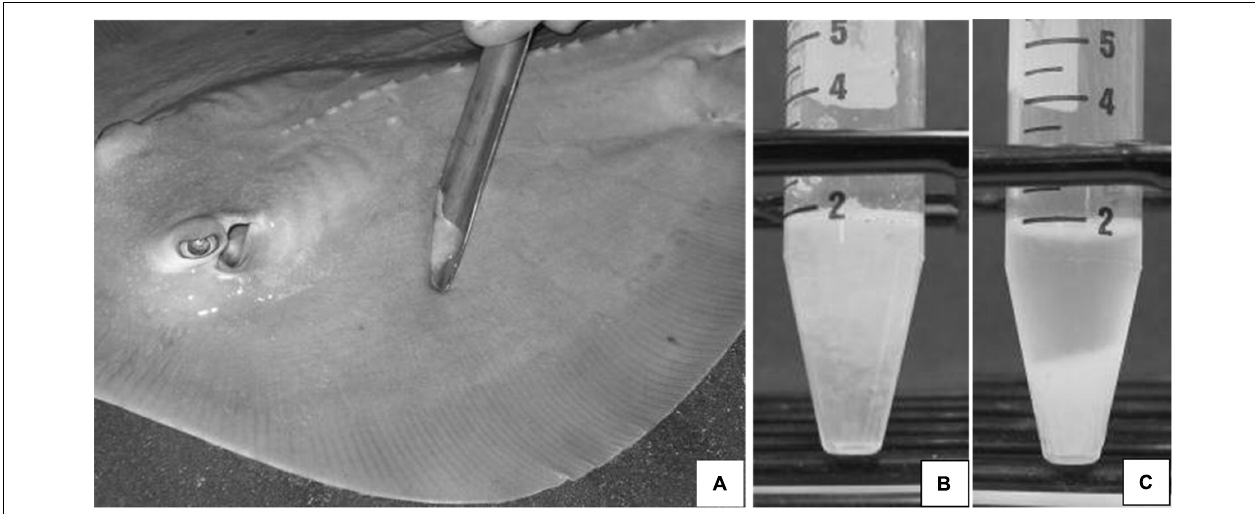
FIGURE 1 | (A) Epidermal mucus is collected by passive scraping of the pectoral fin surface of an Atlantic stingray, Dasyatis sabina with a sterile scoopula. Fresh mucus (B) can be separated into an aqueous supernatant and a mucus pellet (C) following centrifugation at 2,600 × g for 20 min at 4 ◦